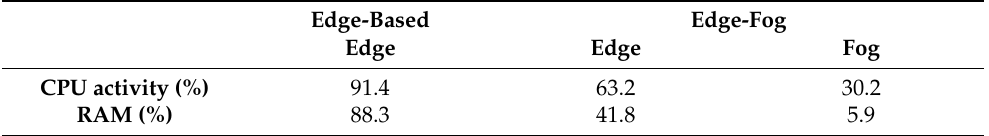
Table 2. CPU activity and peak RAM results for both edge-based and edge-fog